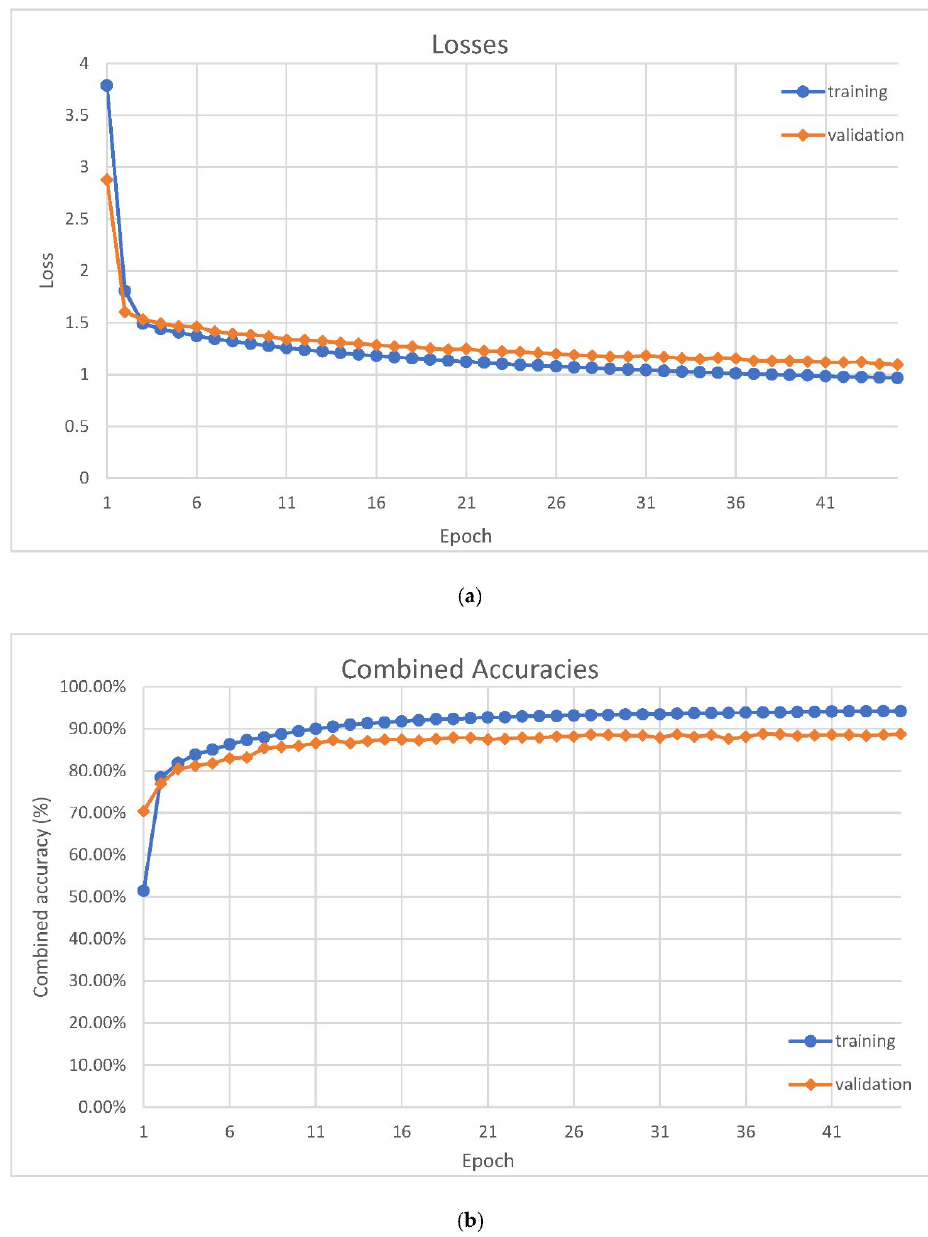
Figure 6. ( a ) Losses are plotted against epoch throughout the training. ( b ) Combined accuracies are plotted against epoch throughout the training. A combined accuracy is the mean of the verification true positive rate (TPR), verification false positive rate (FPR), and the identification accuracy.